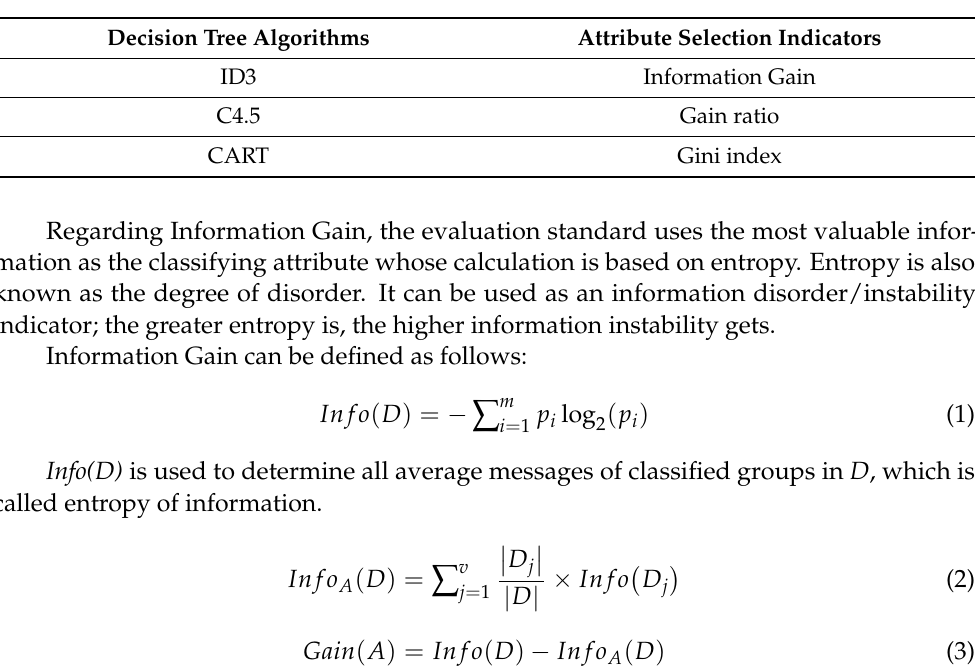
Table 1. Attribute selection